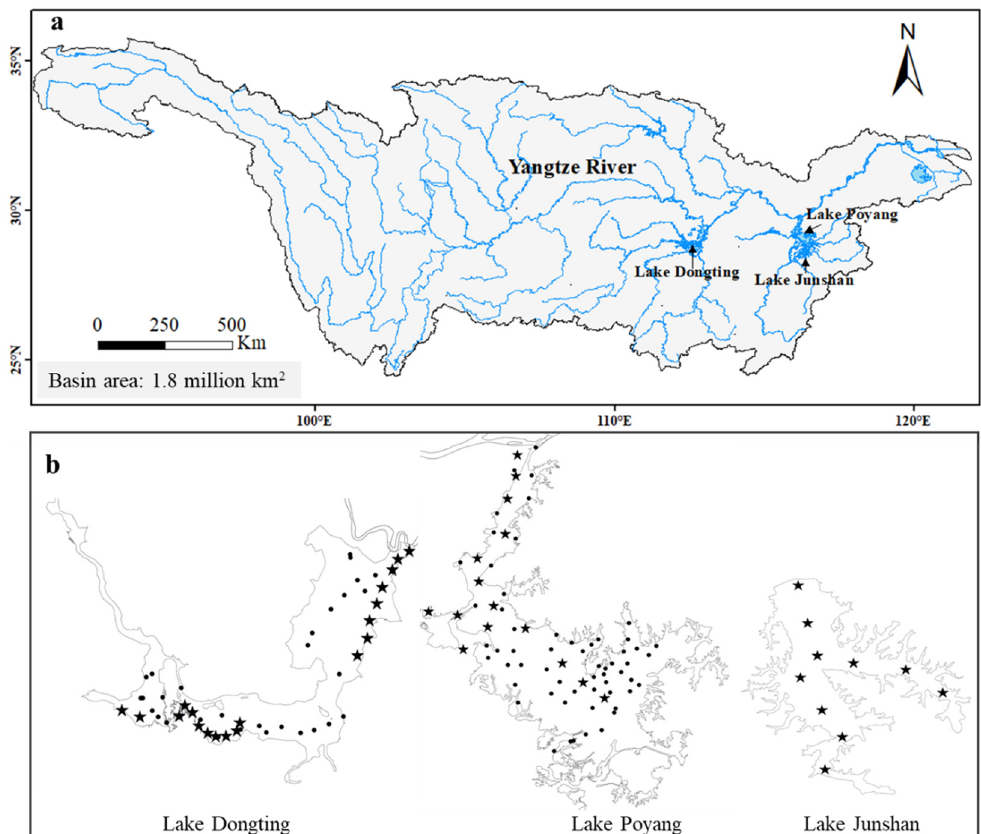
Figure 1. Location of lakes Poyang (PY), Dongting (DT), and Junshan (JS) in the Yangtze River basin ( a ). The enlarged drawings ( b ) show sampling sites only in the high water level season (solid dots) and sites in the high and low water level season (stars).